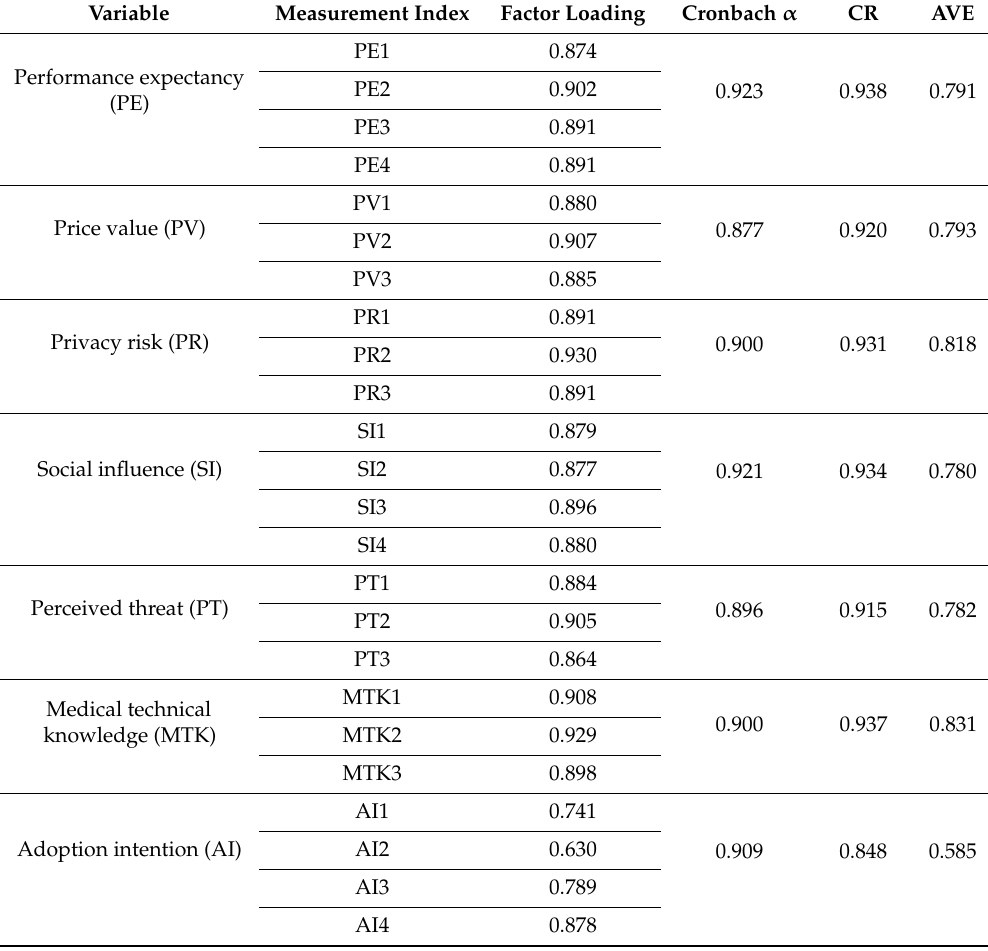
Table 3. Reliability and validity